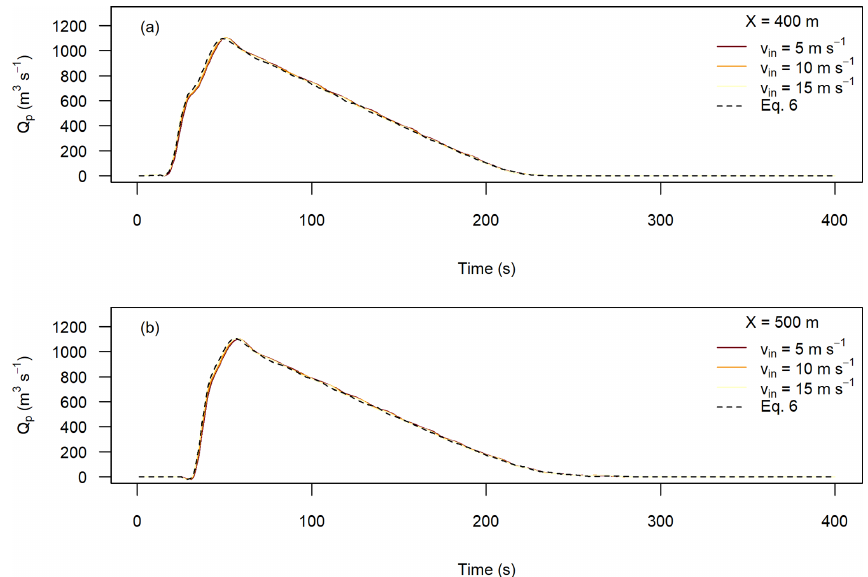
Figure A4. Sensitivity to initial velocity using the numerical flume with particles added at x = 300m.